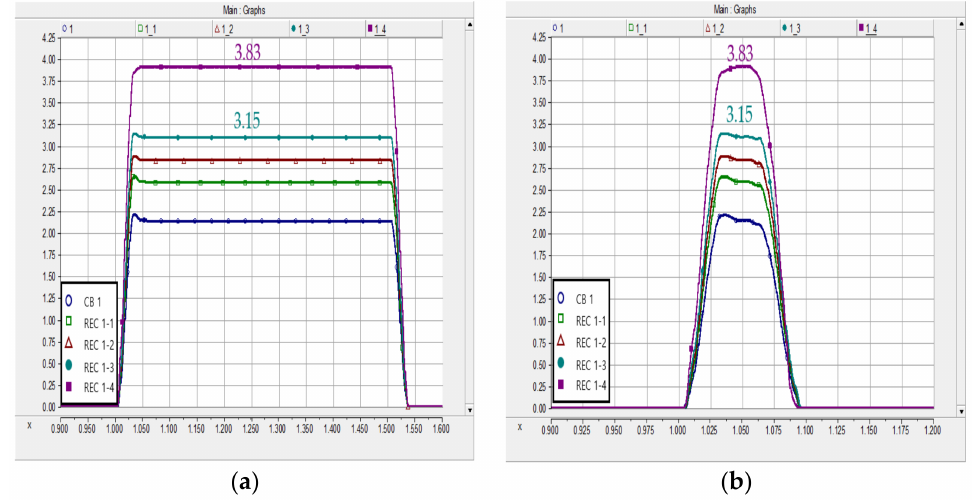
Figure 11. Ground fault simulation: measured values for each breaker of feeder 1. ( a ) Before applying algorithm; ( b ) after applying algorithm.